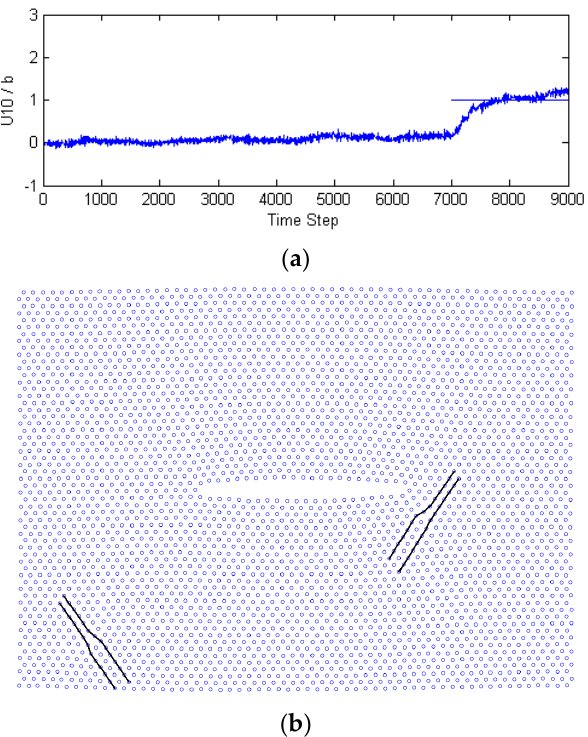
Figure 4. Temperature 300 K, biaxiality ratio α = 0.7, the last emission of < 111 > {112} dislocation: ( a ) the shear displacement U10 / b during the emission (left crack tip, layer 15); ( b ) 2D visualization of the dislocation emission at time step 8000 ( K A (t) = 0.803 MPa · m 1 / 2 ) on a middle (110) plane (layer 15). On the right-hand side—generation of the dislocation, on the left-hand side—a complete dislocation with an edge character with U10 / b = 1.